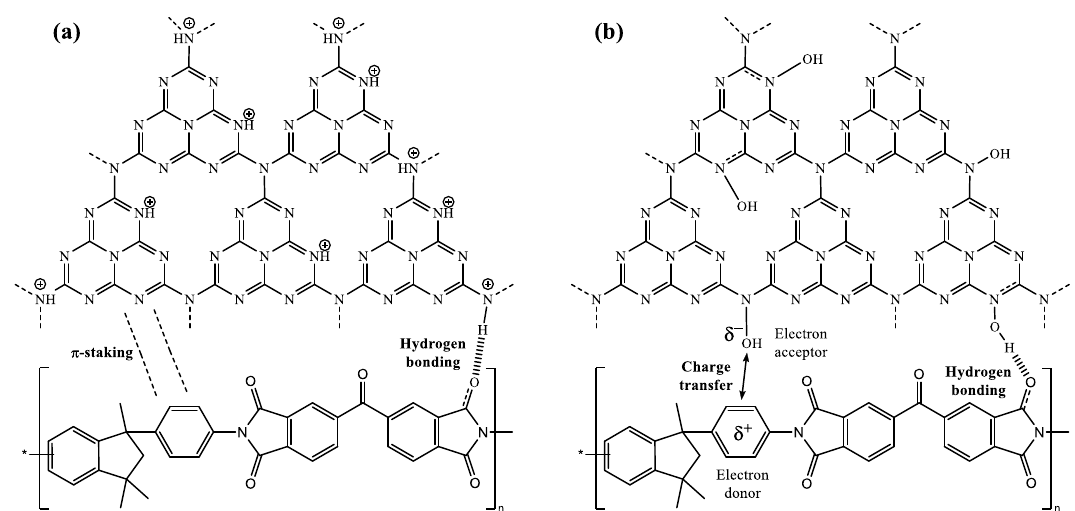
Figure 6. ( a ) Linking modes between protonated g-C 3 N 4 and Matrimid; ( b ) a possible linking mode between oxygen plasma-treated g-C 3 N 4 and Matrimid.